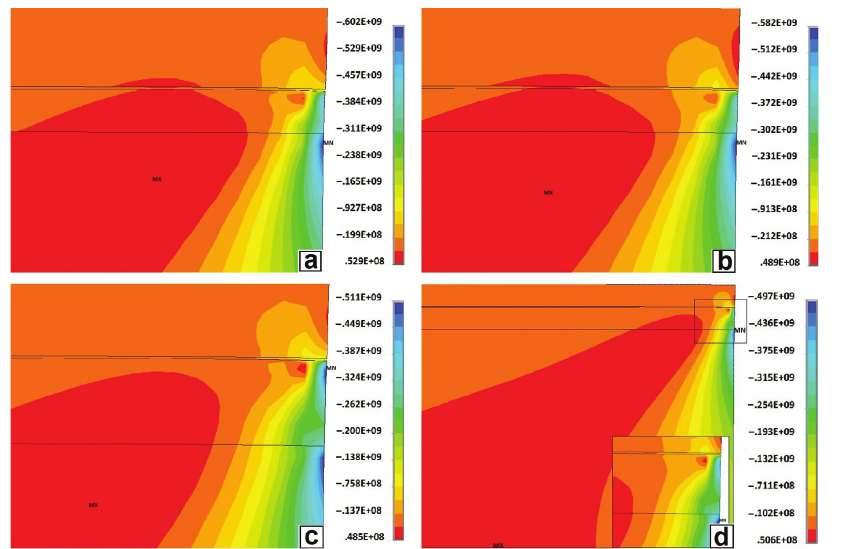
Figure 7: Contour plot of axial stress ( σ yy ) distribution in (left) traditional and (right) nanostructured YSZ coatings at 100 μ m (a, b) and 200 μ m (c, d) bond coat thicknesses.